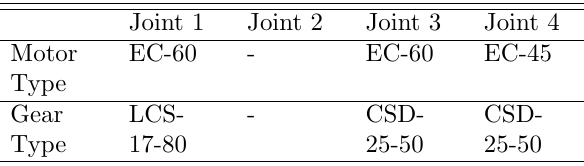
Table 8: Actuation of the UB-AXO. Joints 1 and 3 are the active joints in the shoulder mechanism and joint 4 is the elbow joint. Joint 2 is the passive degree of freedom of the